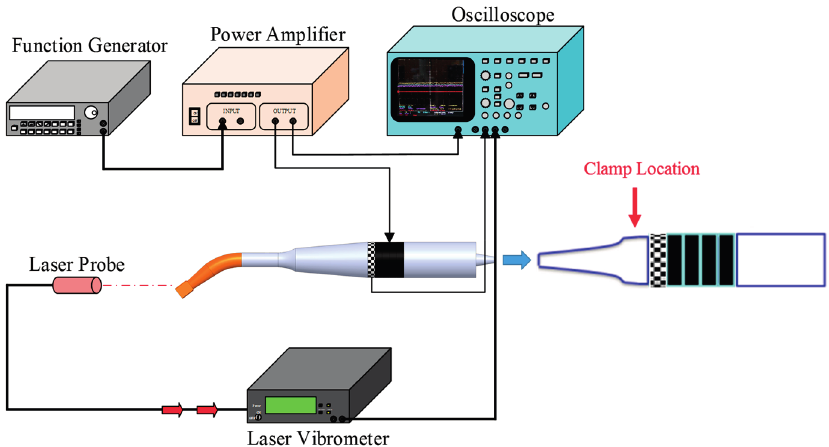
Figure 4. Experimental set-up for measuring the longitudinal displacement of the actuator and the sensor